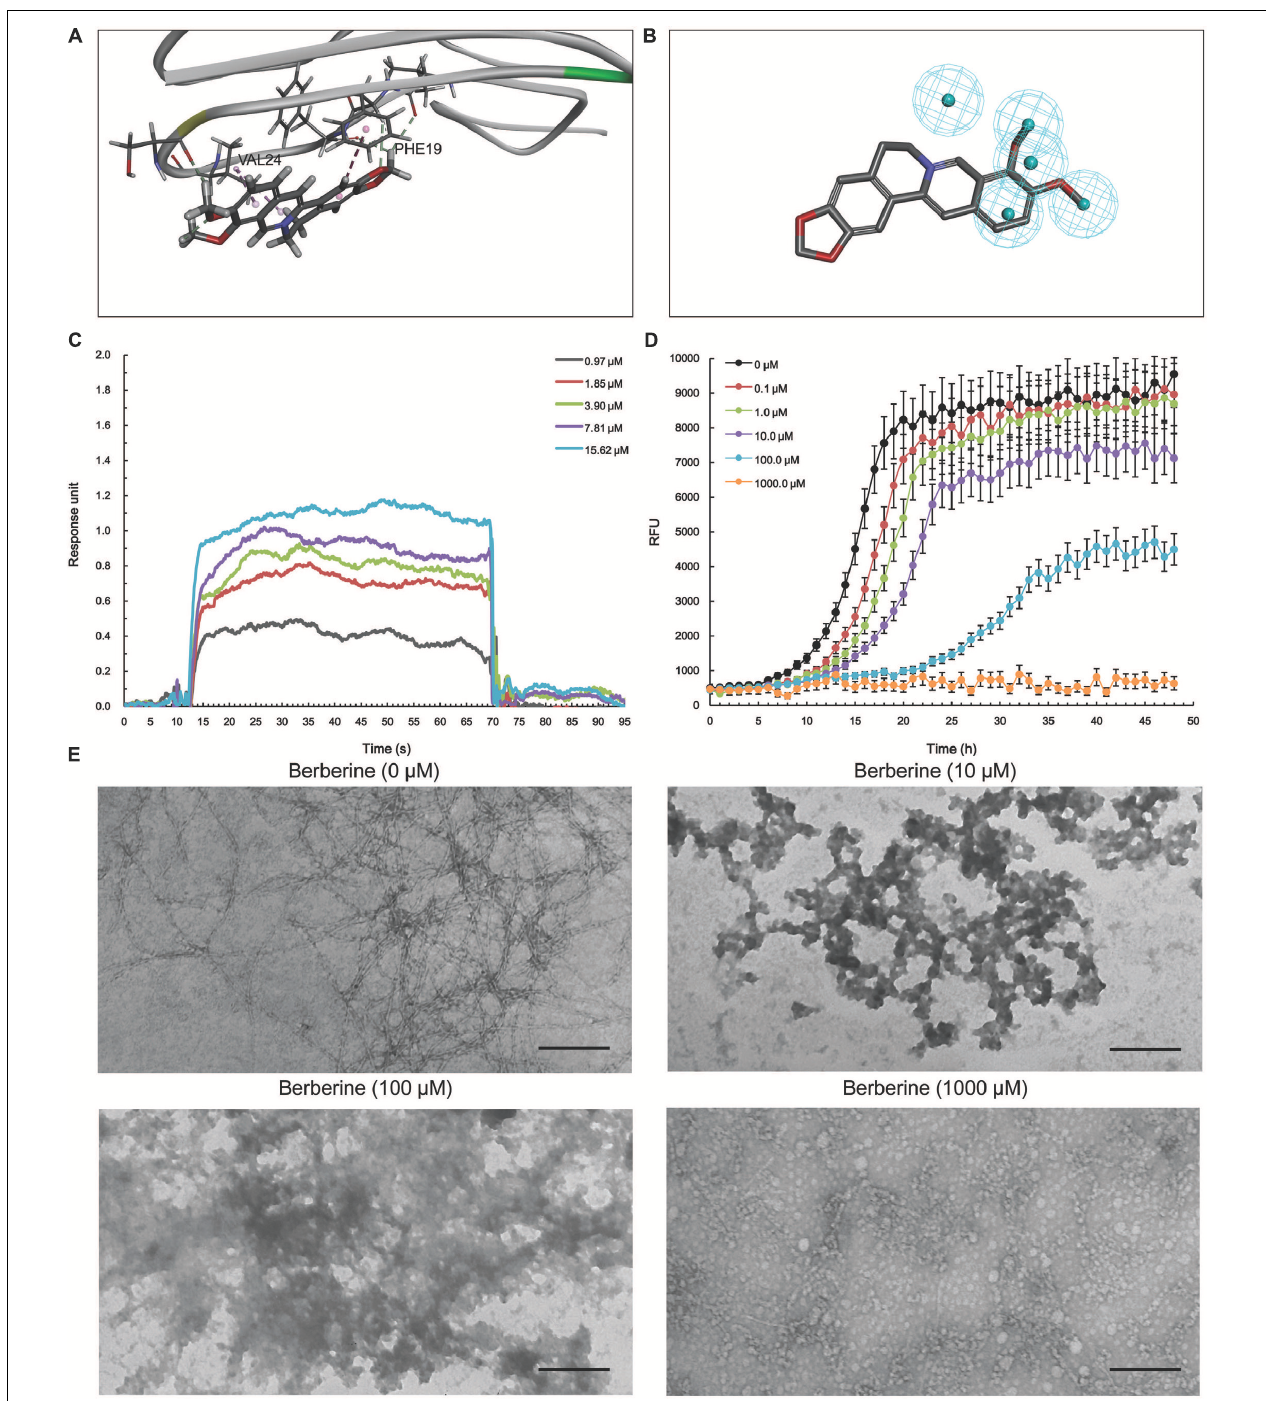
FIGURE 4 | The action of berberine on A β 1 - 42 oligomer. (A) The binding motif of berberine within A β 1 - 42 oligomer. Secondary structures are depicted as ribbons (coils, α -helices; arrows, β -sheets). Color-coding is based on the secondary structures ( α -helices, red; β -sheets, skyblue; loops, green). The berberine and key residues are shown as sticks with carbon, oxygen and nitrogen colored gray, red, and blue. Electrostatic interactions are shown as dashed lines with π -alkyl groups colored pink. (B) The pharmacophore model of berberine obtained for A β 1 - 42 oligomer. The colored spheres identify the position and the type of binding features (hydrophobic portions, cyan). (C) The binding of berberine to A β 1 - 42 oligomer. The association and dissociation of berberine with immobilized A β 1 - 42 oligomer was analyzed using SPR. (D) The inhibition of A β 1 - 42 seeding capacity by berberine. The aggregation kinetics of A β 1 - 42 in the absence or presence of berberine were monitored by incorporation of ThT. Error bars represent the SD of eight replicates. (E) The TEM images of A β 1 - 42 aggregation with or without berberine at 37 ◦ C for 48 h. The scale bars indicate 100 nm. Magnification: 50,000 × .